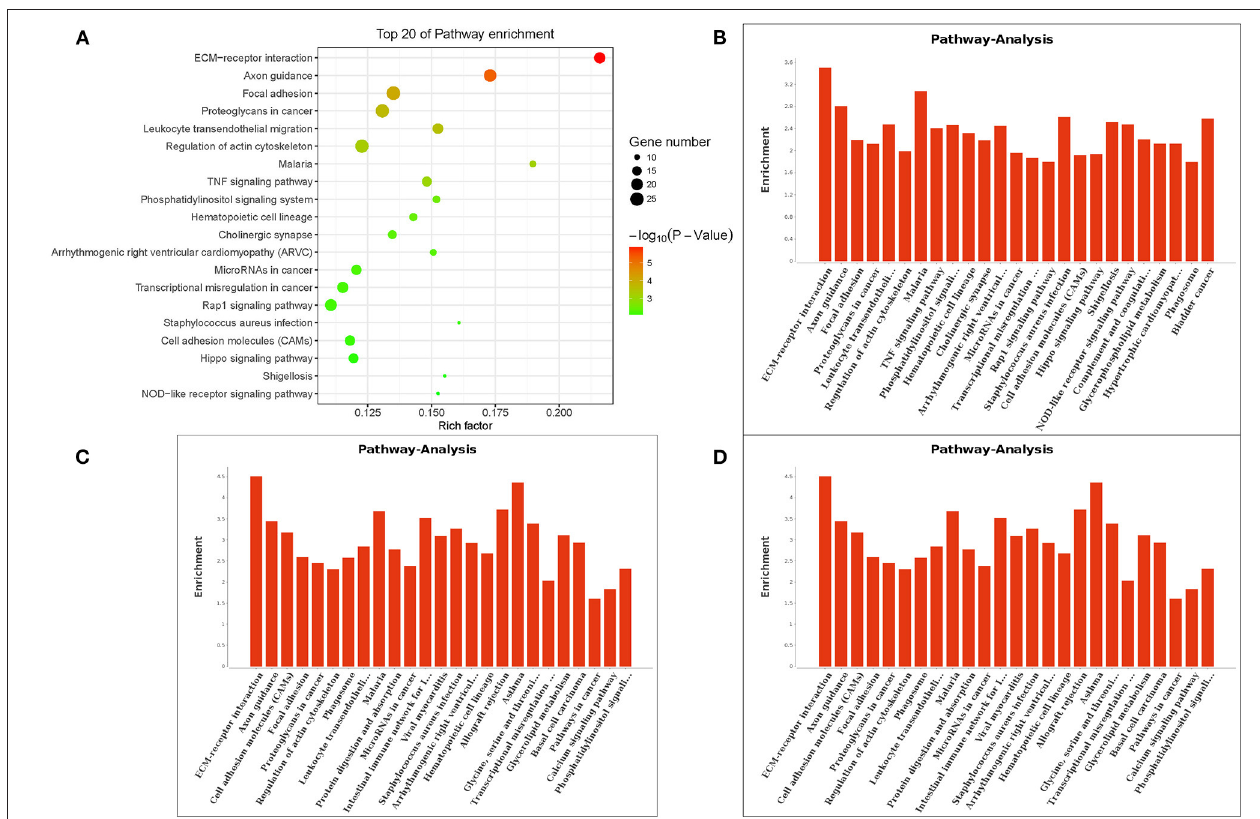
FIGURE 5 | Enriched KEGG pathways of DGEs in ACADSB − / − bMECs. (A) The top 20 enriched pathways for DEGs. (B) Pathway terms of DEGs. (C) Pathway terms of down-regulated genes. (D) Pathway terms of up-regulated genes. KEGG, Kyoto Encyclopedia of Genes and